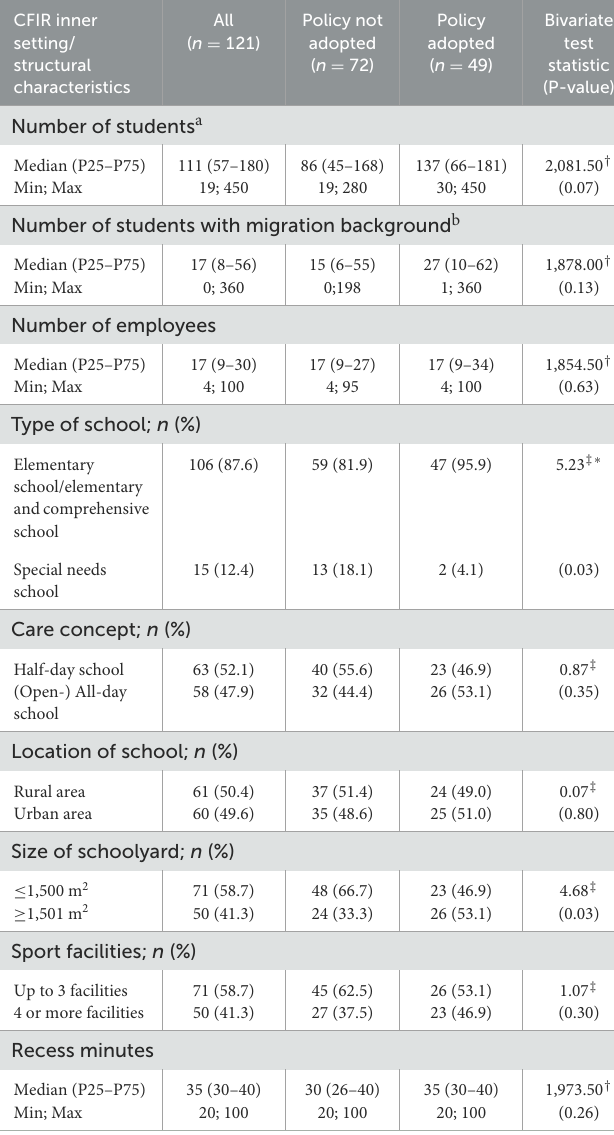
TABLE 2 Descriptive and bivariate analyses of CFIR determinants of the construct structural characteristics with policy adoption (n = 121 schools). CFIR inner setting/ structural